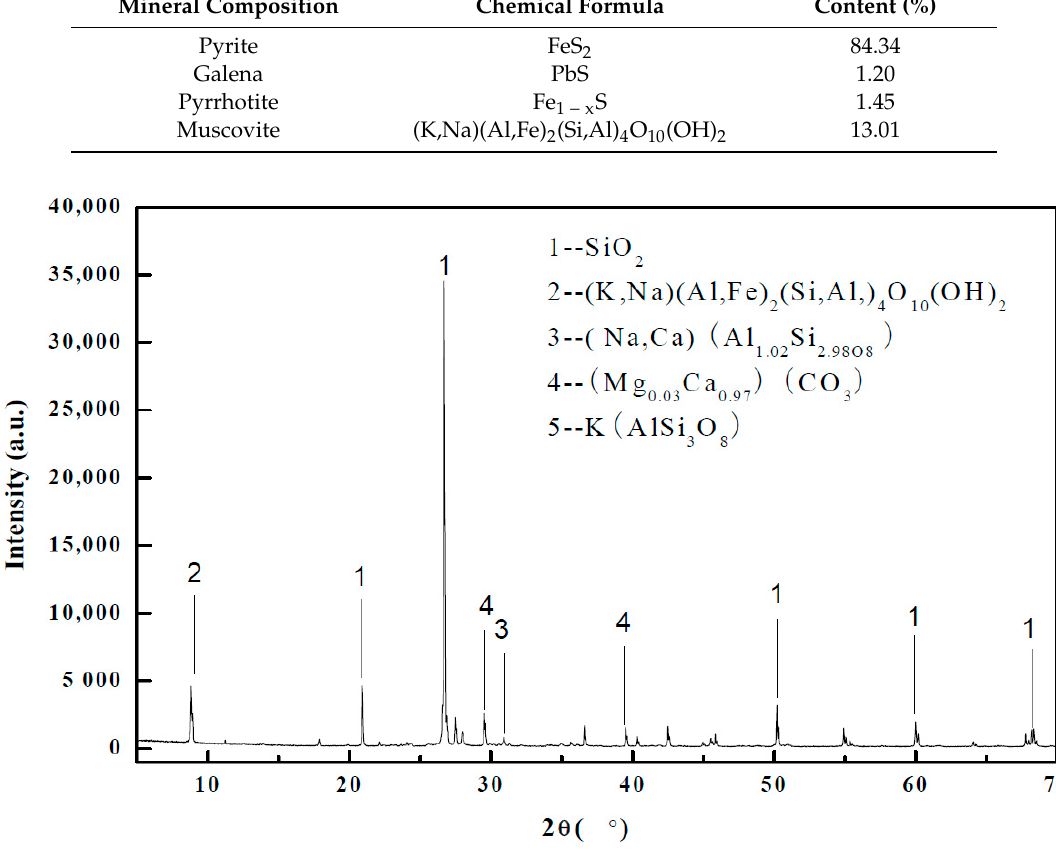
Figure 10. XRD detection and analysis of the tailings composition. Table 6. Mineral composition content of tailings.